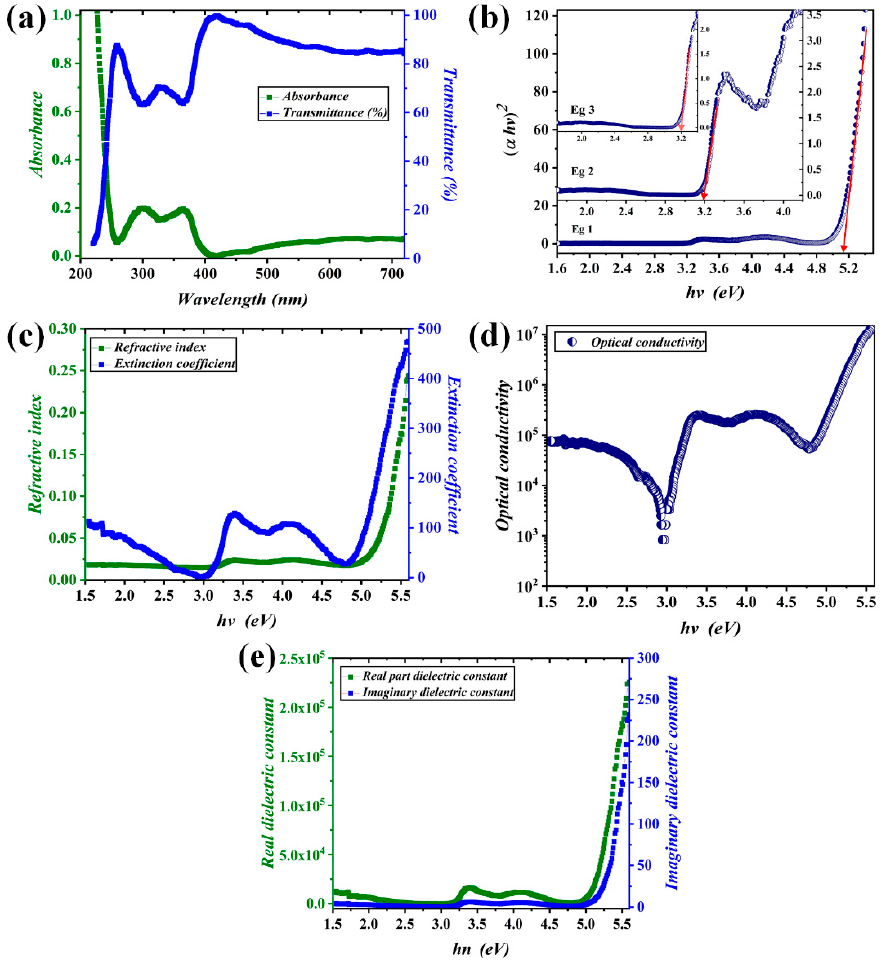
Figure 3. Variation of LDH parameters; ( a ) absorbance and transmittance, ( b ) energy band gap, ( c ) refractive index and extinction coefficient, ( d ) dielectric constant, and ( e ) optical conductivity.